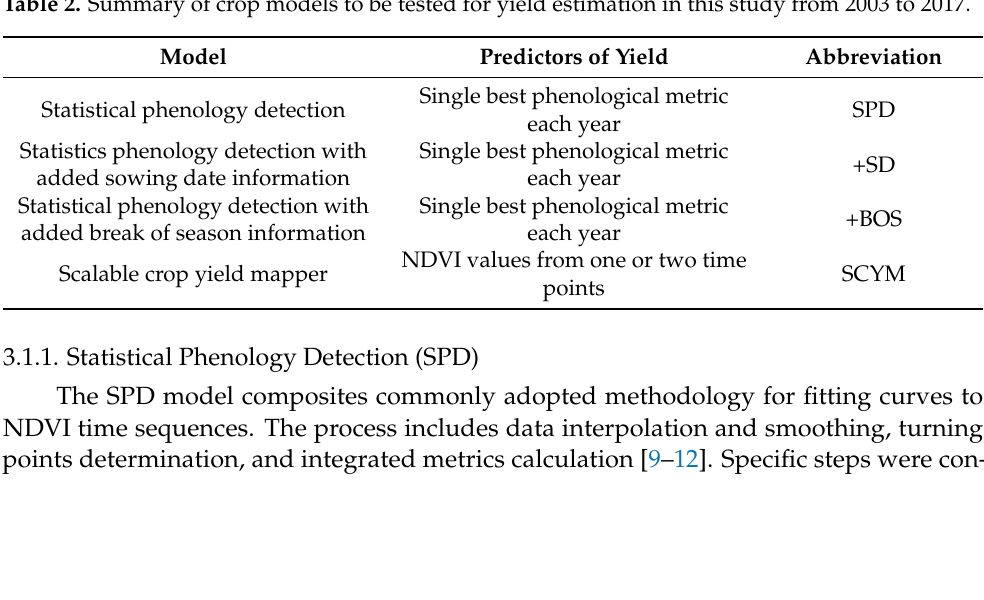
Table 2. Summary of crop models to be tested for yield estimation in this study from 2003 to